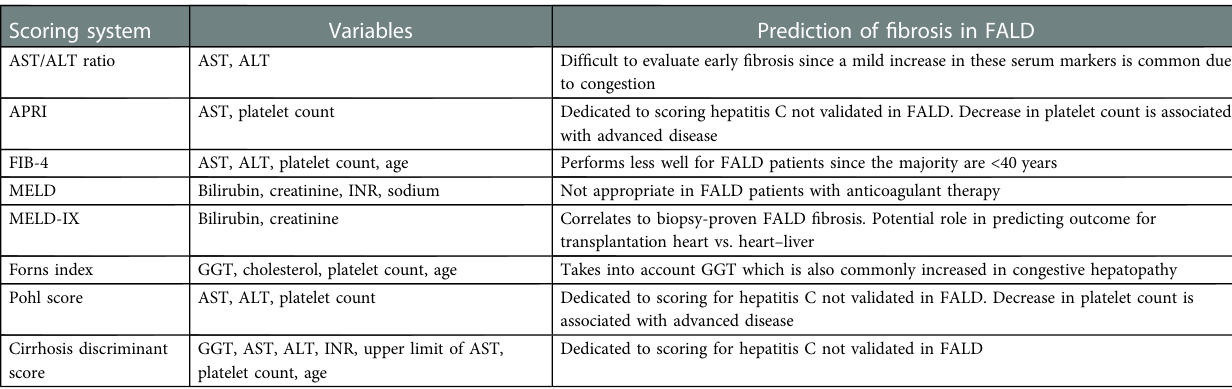
TABLE 1 Laboratory scoring